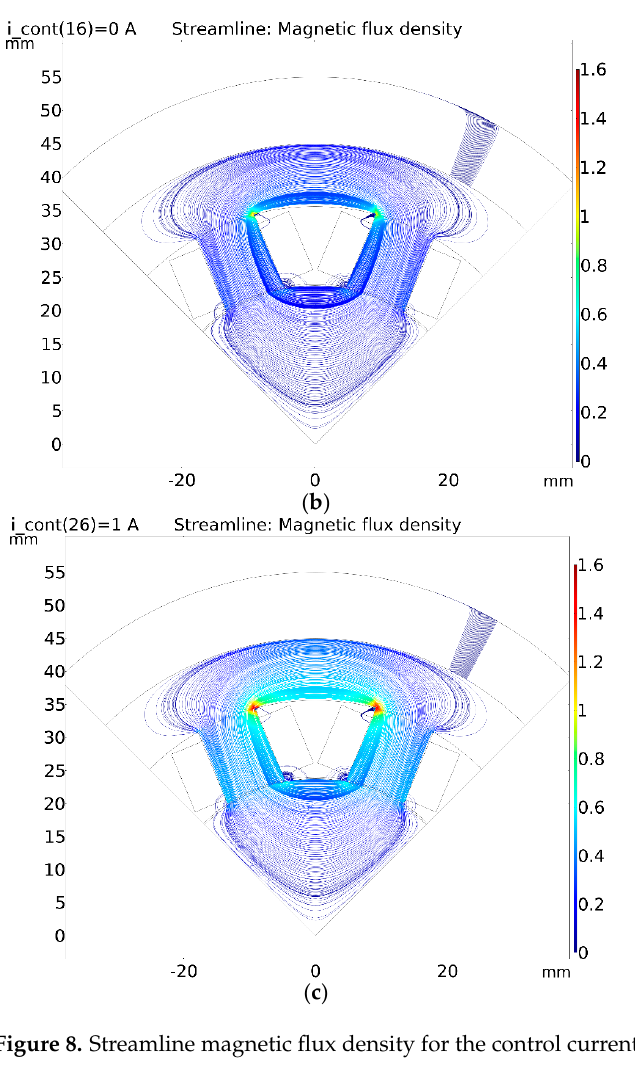
Figure 8. Streamline magnetic flux density for the control current of − 1 A ( a ), 0 A ( b ), and 1 A ( c ).